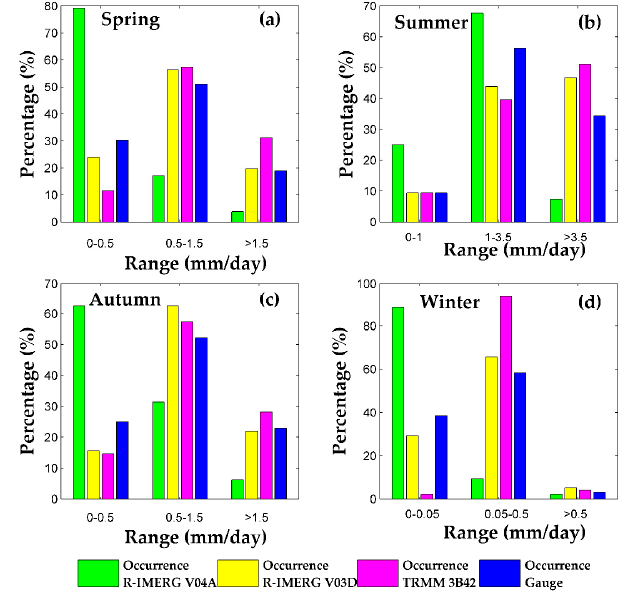
Figure 5. The precipitation intensity distribution for each season’s daily average precipitation for different precipitation intensity classes over the Tibetan Plateau between June 2014 and November 2015.